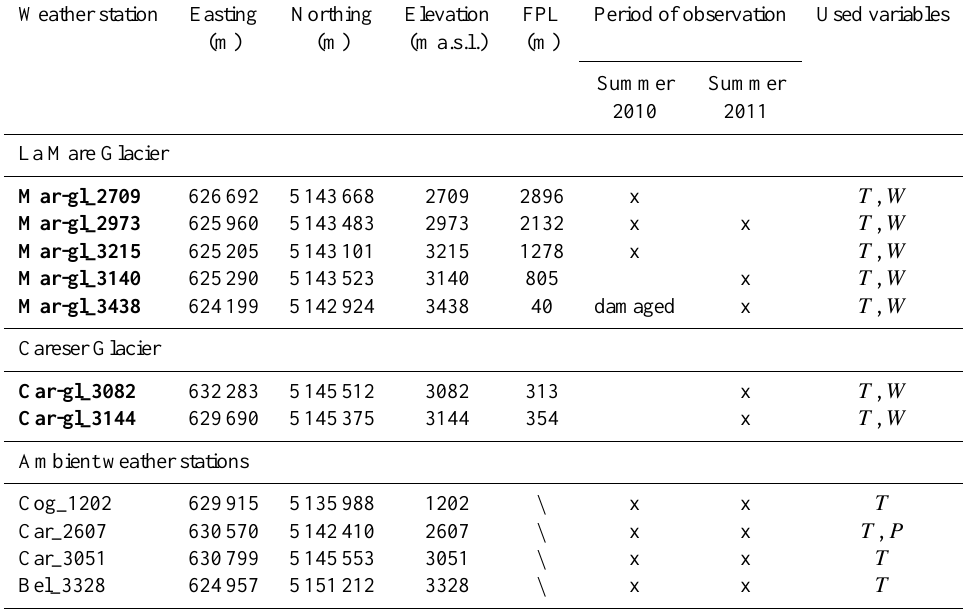
Cog_1202 5135988